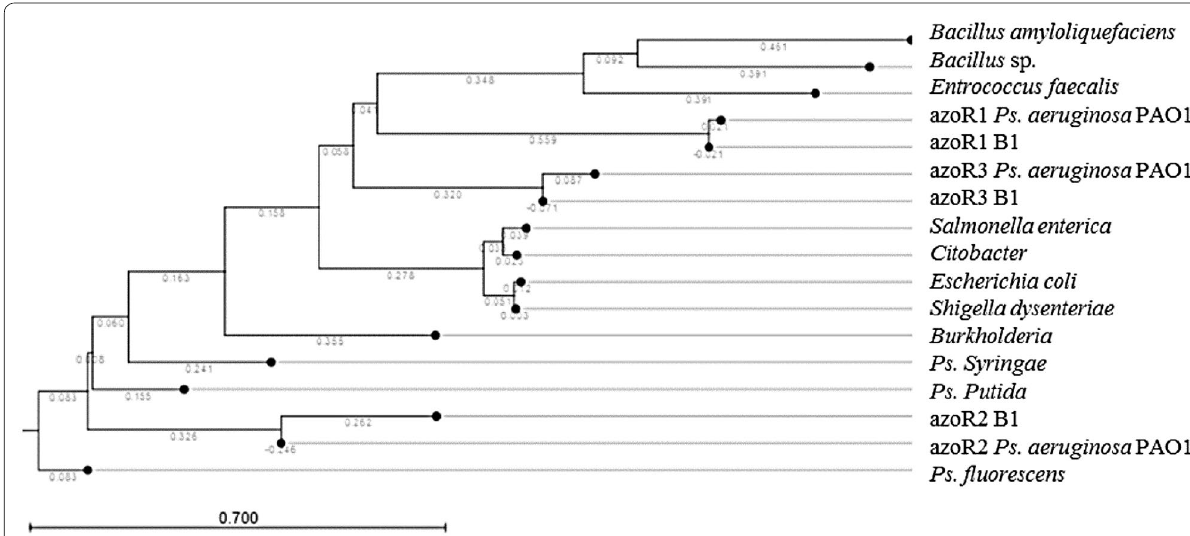
Fig. 3 phylogenetic tree of Pseudomonas aeruginosa (B1 isolate), Pseudomonas aeruginosa PAO1 (reference strain) and other bacterial species. Pseudo Phylogentic tree was generated using azo-reductase protein sequences showing the evolution distances, represented by numbers written on branches, from hypothetical ancestors represented by nodes between the isolated Pseudomonas aeruginosa and different bacteria show- ing high relatedness between different strains of Pseudomonas aeruginosa and high variations when compared to other bacterial species. The tree was generated by CLC workbench 5 software